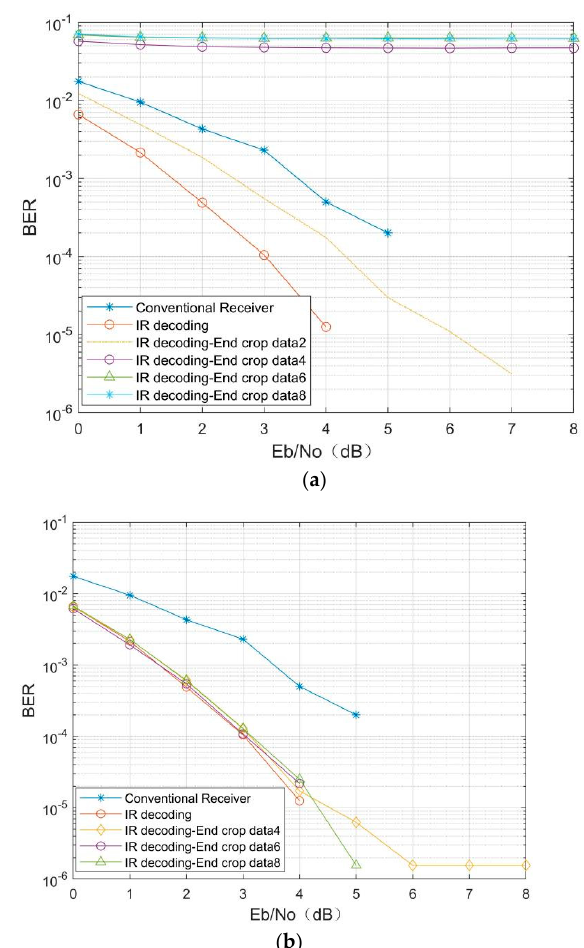
Figure 11. Data end-crop receiver performance. ( a ) Intelligent receiver performance under different cropped data in AWGN channel. ( b ) Performance of different end-crop receivers with end data re- moved.